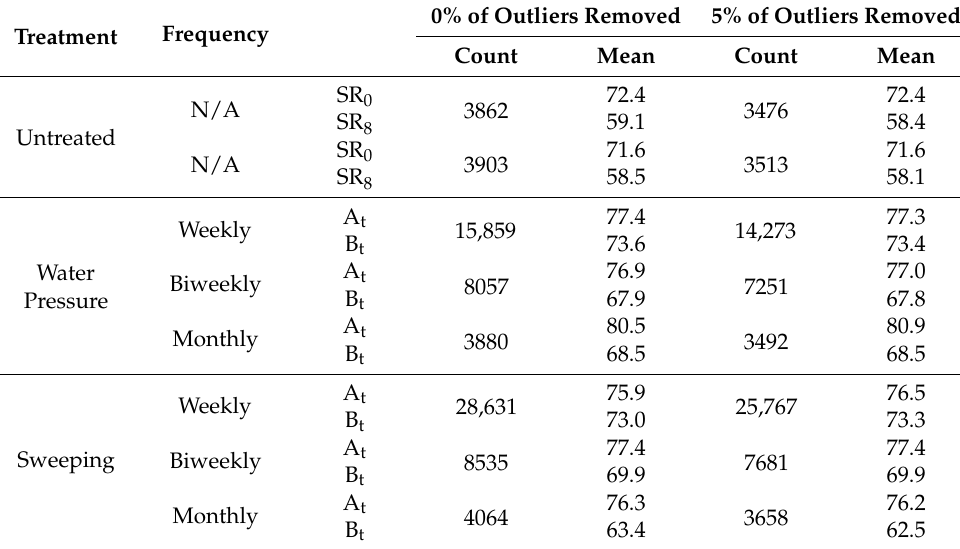
Table 4. Count and mean SR of the data set and without 5% of